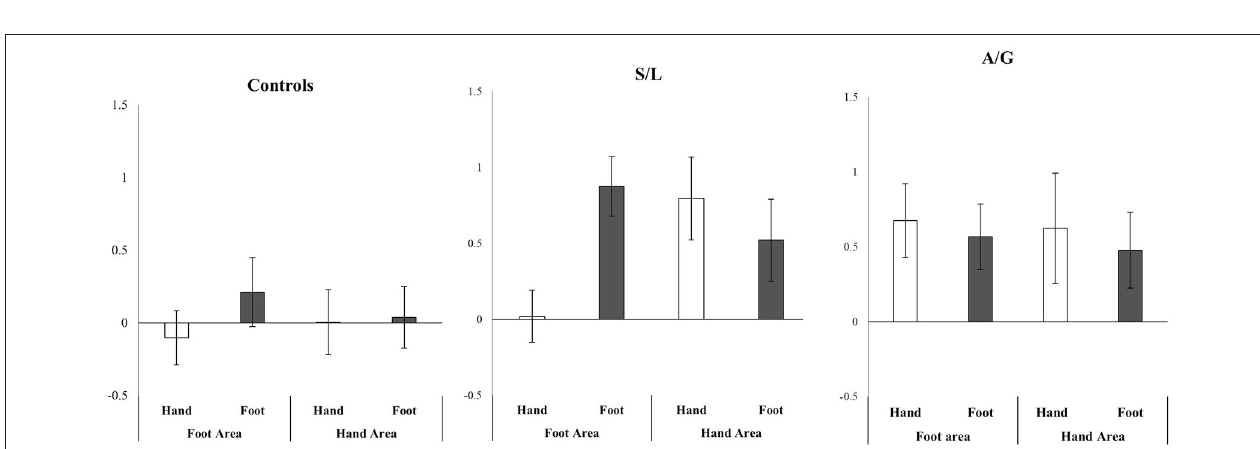
FIGURE 5 | (A) Averaged parameter estimate betas extracted from each ROI are displayed for each group. Results of between group ANOVAs are displayed and significant effects are denoted with * p < 0.05. Error bars show ± 1 SEM. (B) Script plots for showing the individual beta values extracted for the ROI analysis.